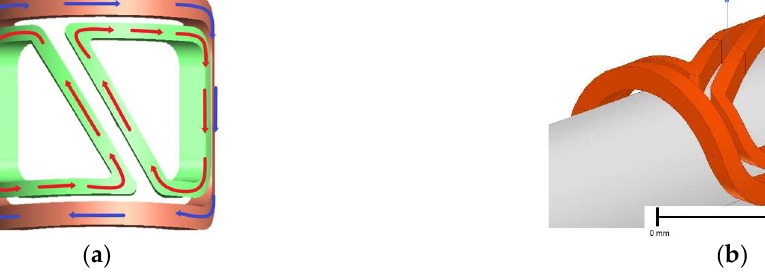
Figure 19. Concept probe with the best performance simulated. ( a ) Top view of the probe with the excitation coil represented in red and the sensing coils in green; ( b ) Probe modeled in Ansys Electronics used for the simulations.